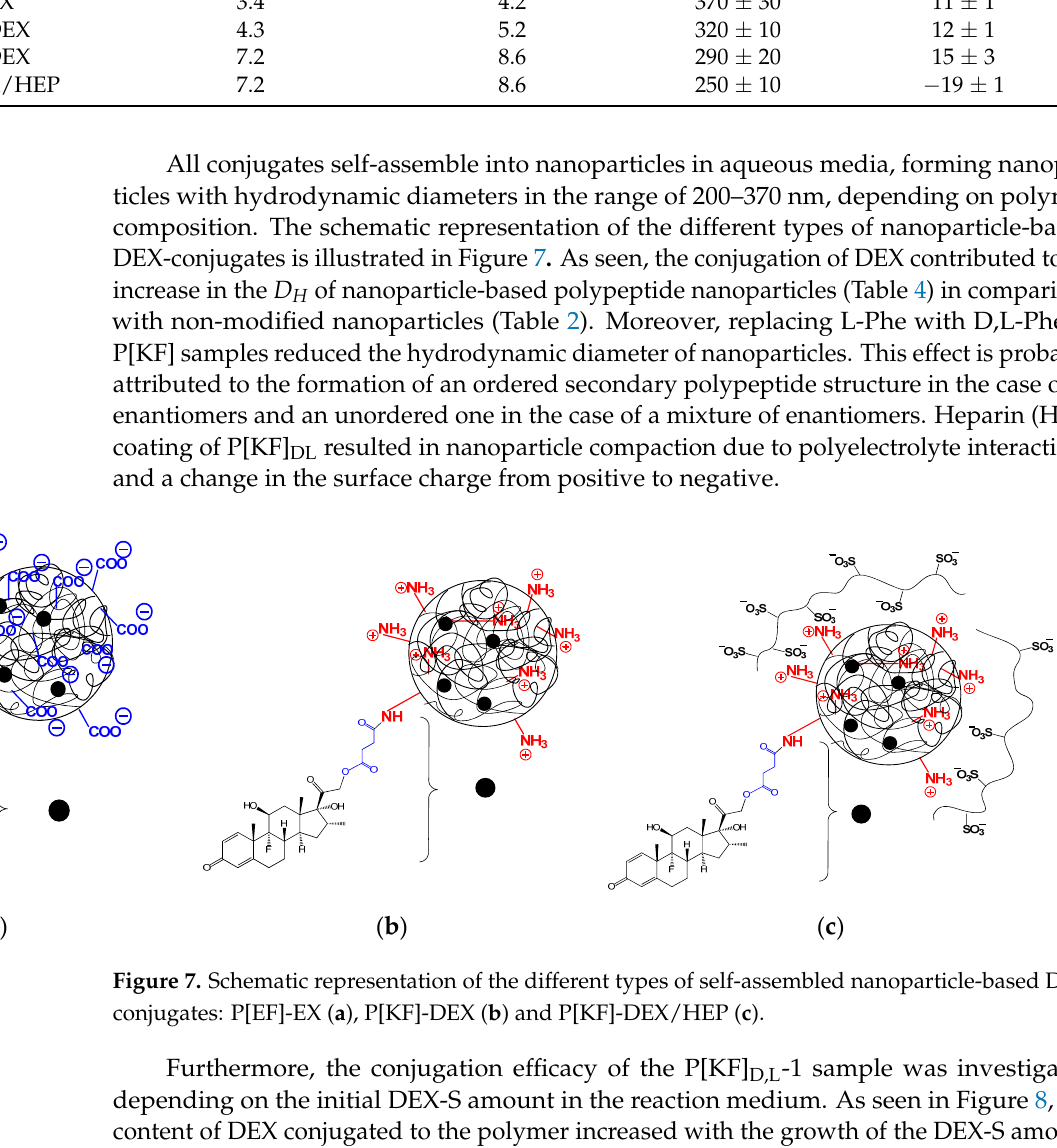
Figure 8. Dependence of DEX-content conjugated to the polypeptide (P[KF] D,L -1) on the amount of DEX-S taken for conjugation. Thus, modification of lysine-based polypeptides with DEX-S is simpler and allows easier variation in DEX loading. At the same time, the positive charge of P[KF] nanopar- ticles is easily overcome by a simple heparin coating, which provides effective surface recharge. Charging the surface of the P[KF] nanoparticles, in turn, completely alters their properties and behavior in the vitreous.